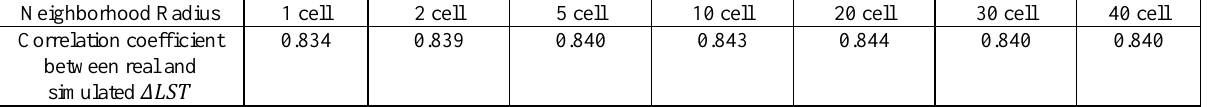
Table 3. relationship between neighborhood size and computed